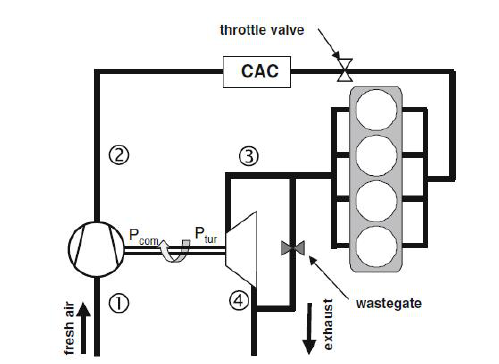
Figure 2. 4 cylinder engine with turbocharger; 1 - compressor, 2 - intake manifold, 3 - exhaust manifold, 4 -